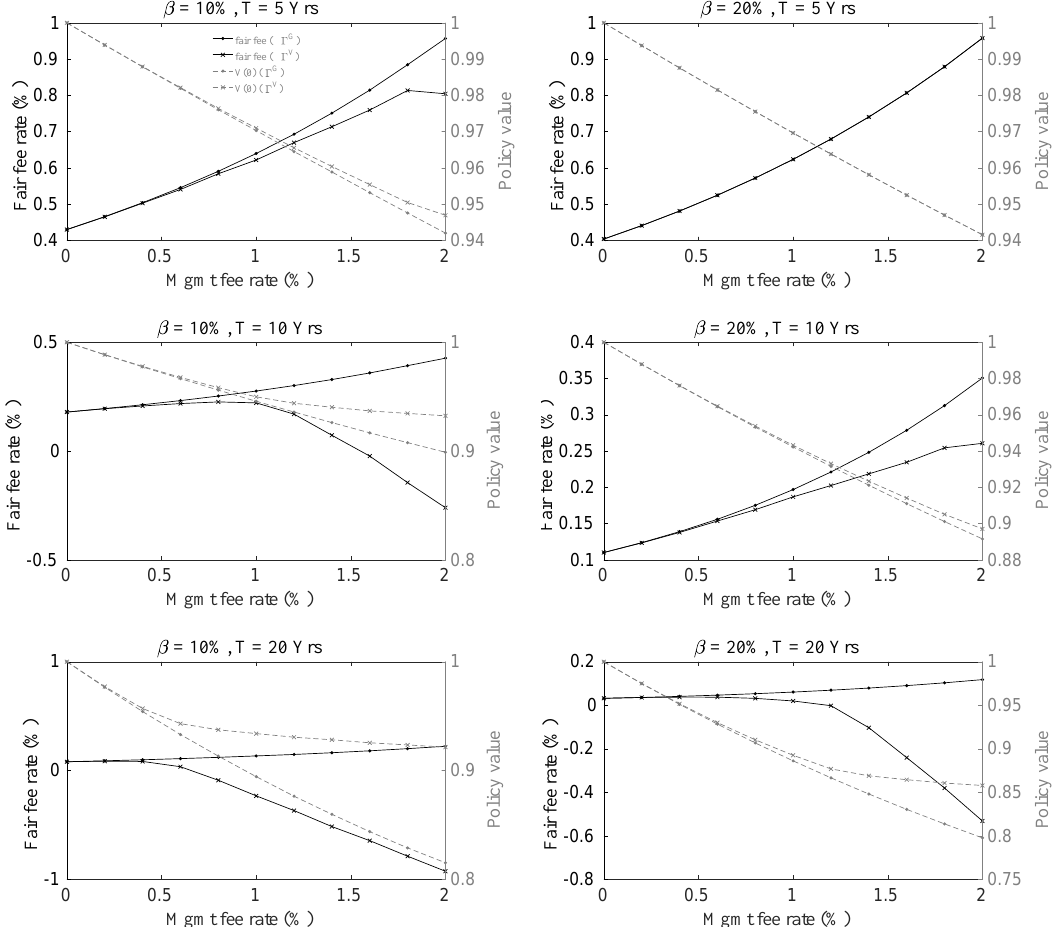
Figure 4. Fair insurance fee rates and policy values as a function of management fee rates α m for risk-free rate r = 5% and volatility σ = 10%, for penalty rates β = 10%,20% and maturities T = 5,10,20 years. The left axis and dark plots refer to the fair fees in percentage; the right axis and gray plots refer to the policy values. Legends across all plots are shown in the upper left